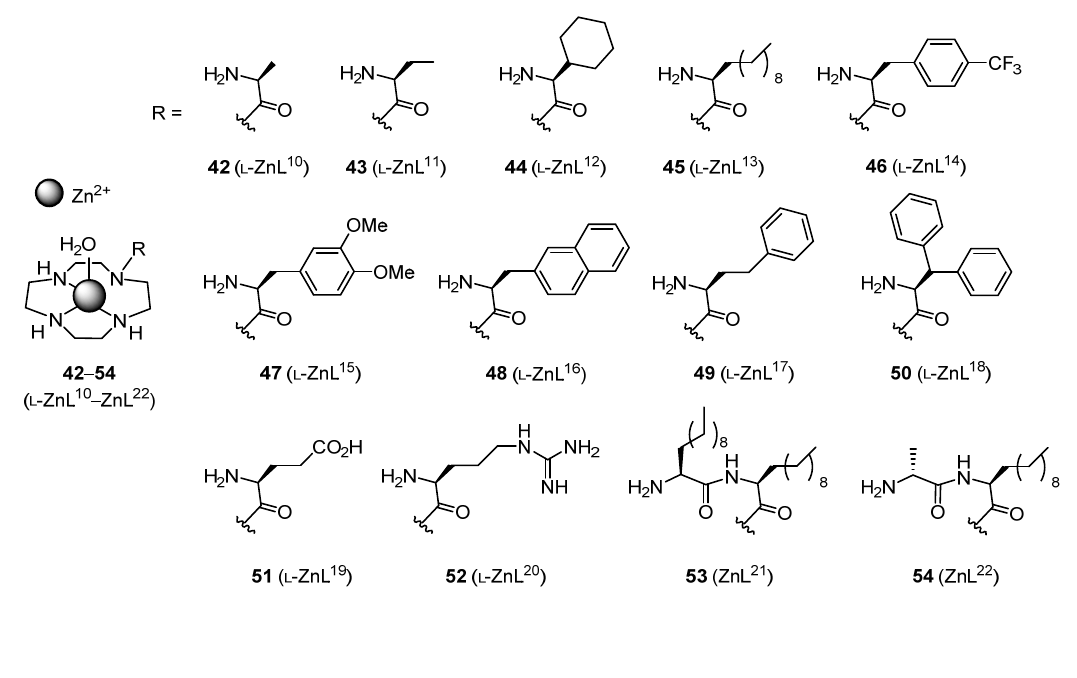
Figure 2. Structures of Zn 2+ complexes containing aliphatic, aromatic, anionic, cationic, and dipeptide side